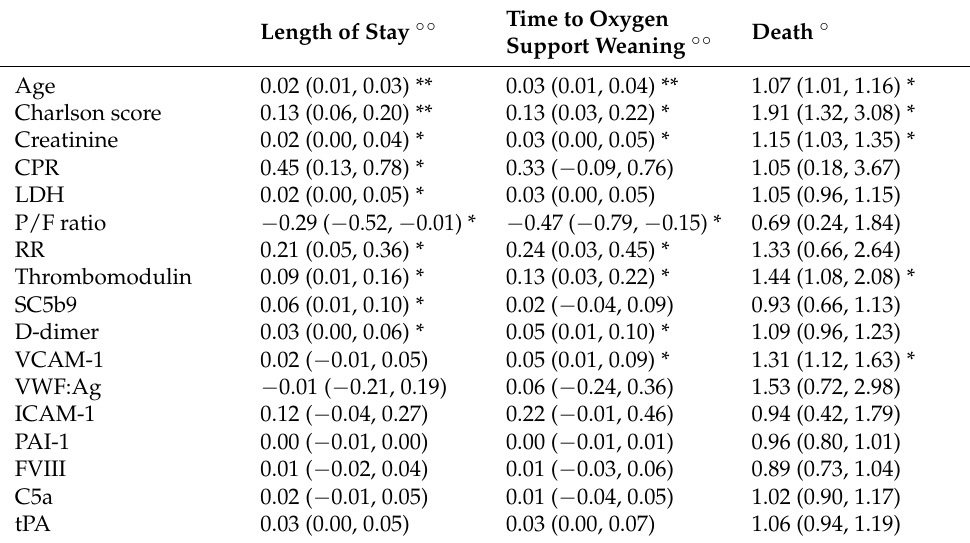
Table 6. Univariate analysis of prognostic factors and different outcomes. Length of Stay ◦◦